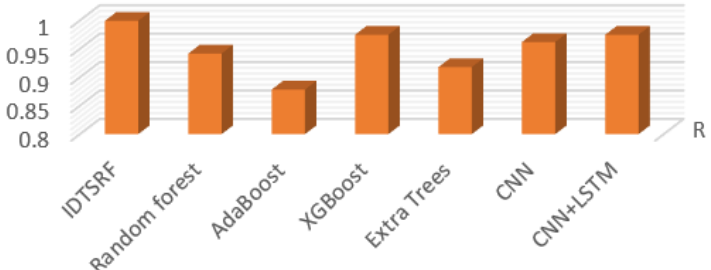
Figure 9. R Comparison chart.